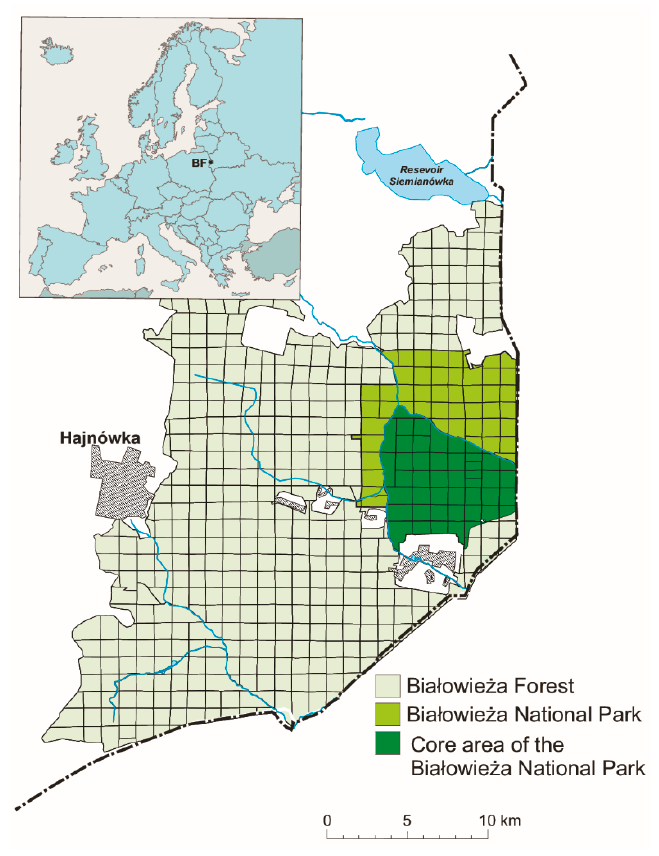
Figure 1. The study site—core area of the Bia ł owie ż a National Park in Eastern Poland.